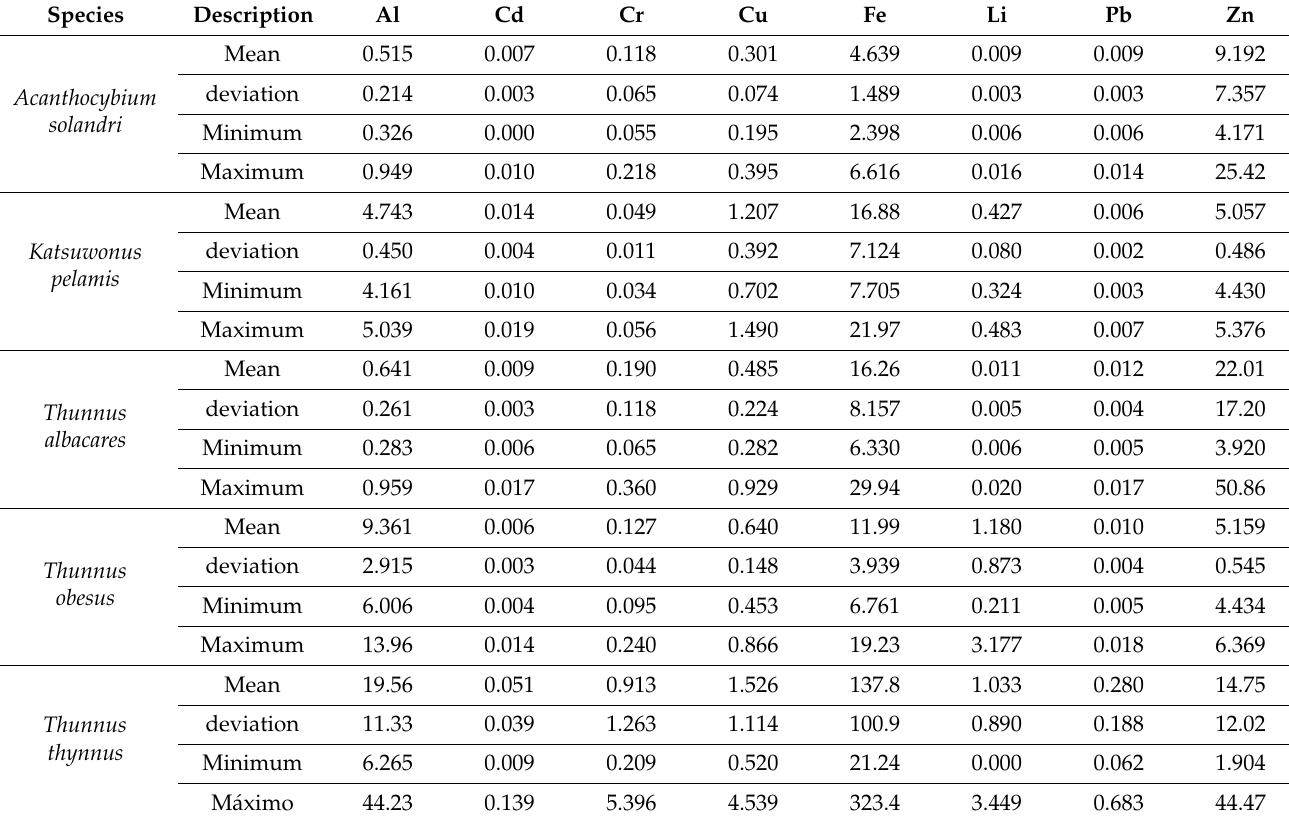
Table 2. Metal concentrations in mg/kg for the five species analyzed (mean and standard